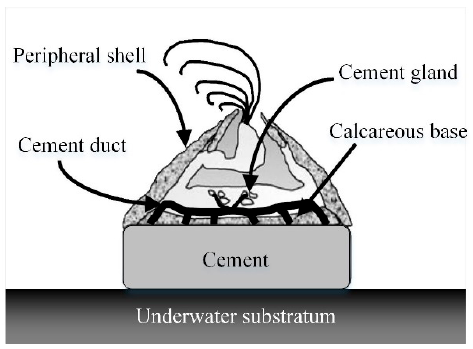
Figure 2. The cross-section of a barnacle on a foreign substratum.